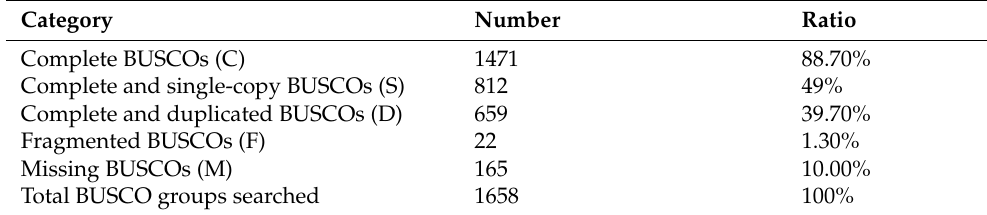
Table 2. BUSCO analysis of the assembled transcripts.